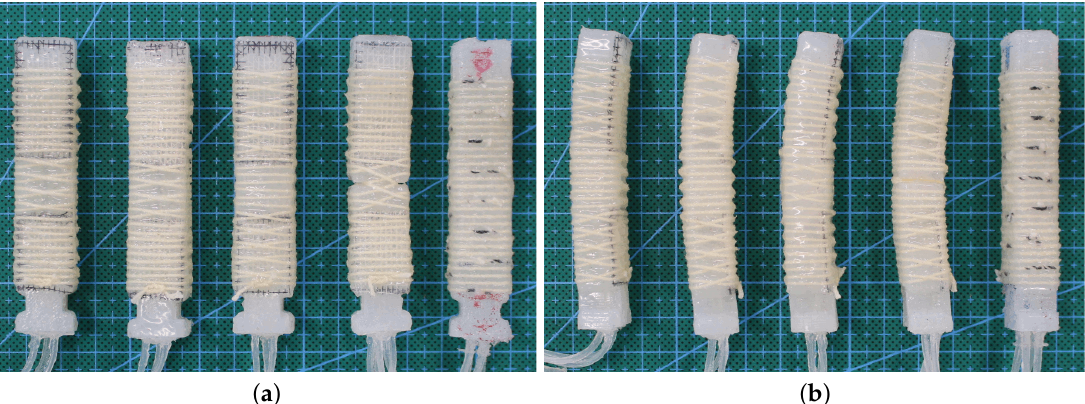
Figure 3. The five prototypes shown from the ( a ) bottom and ( b ) right. From left to right: Simple1-A, Simple2-A, Simple2-B, Opposing-C,